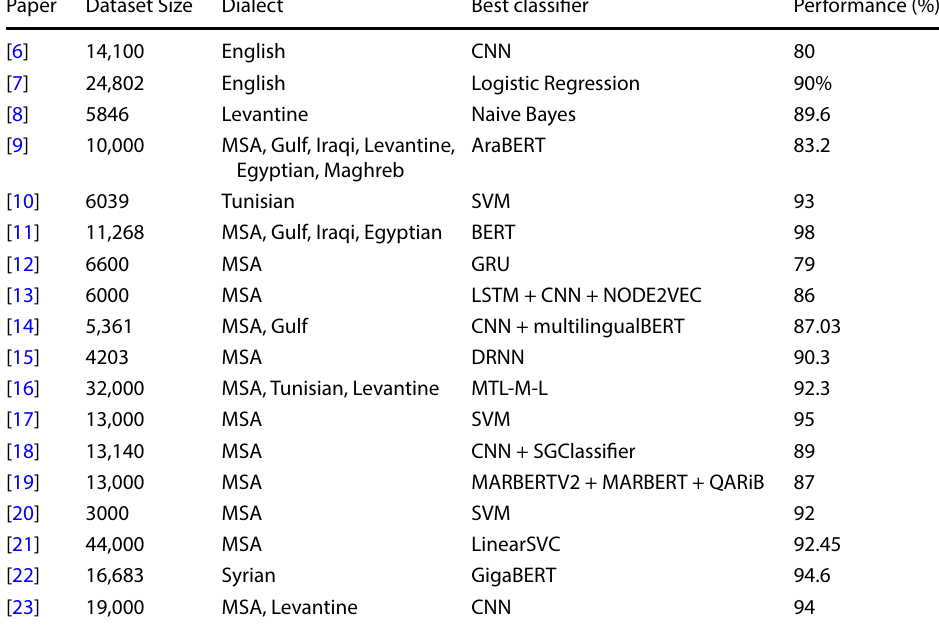
Table 1 Comparison of previous research papers